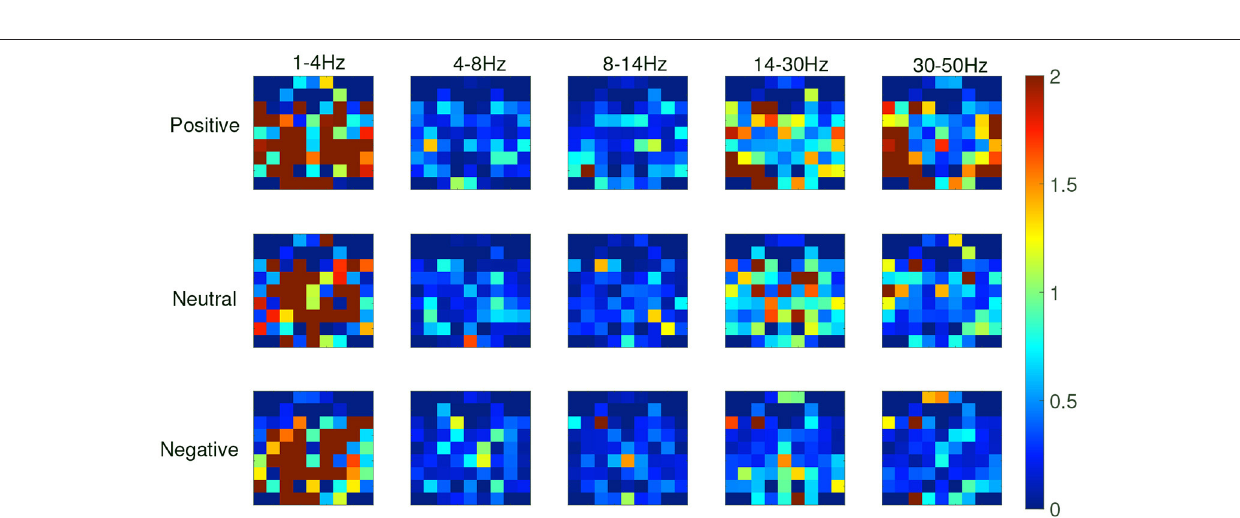
FIGURE 8 | Recognition results of spatiotemporal neural network on depression database.